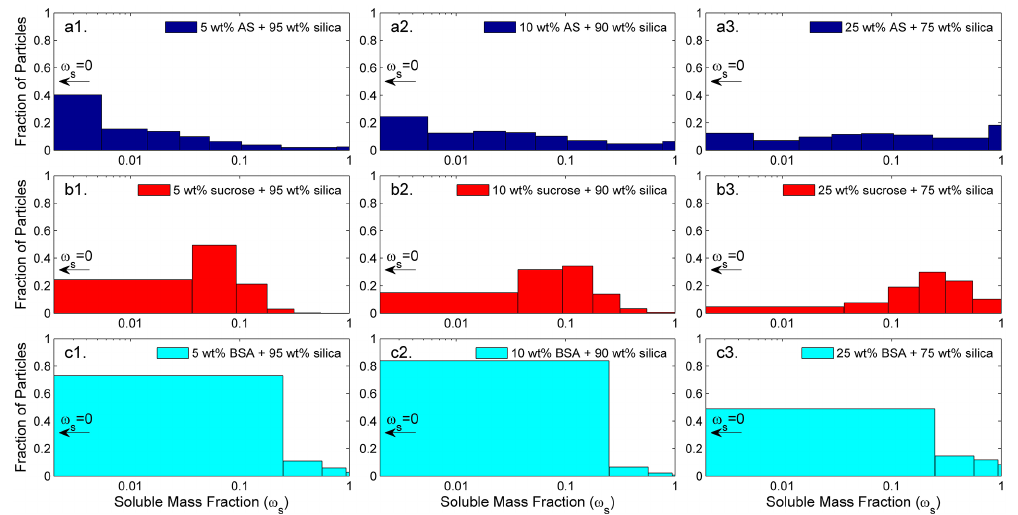
Figure 12. The distribution of soluble material on 150nm (mobility diameter) particles in the mixed particles made of (a1–a3) silica + (NH 4 ) 2 SO 4 (AS), (b1–b3) silica + sucrose, (c1–c3 ) silica + BSA. Note that the smallest solubility bin extends down to zero, i.e. particles consisting of pure